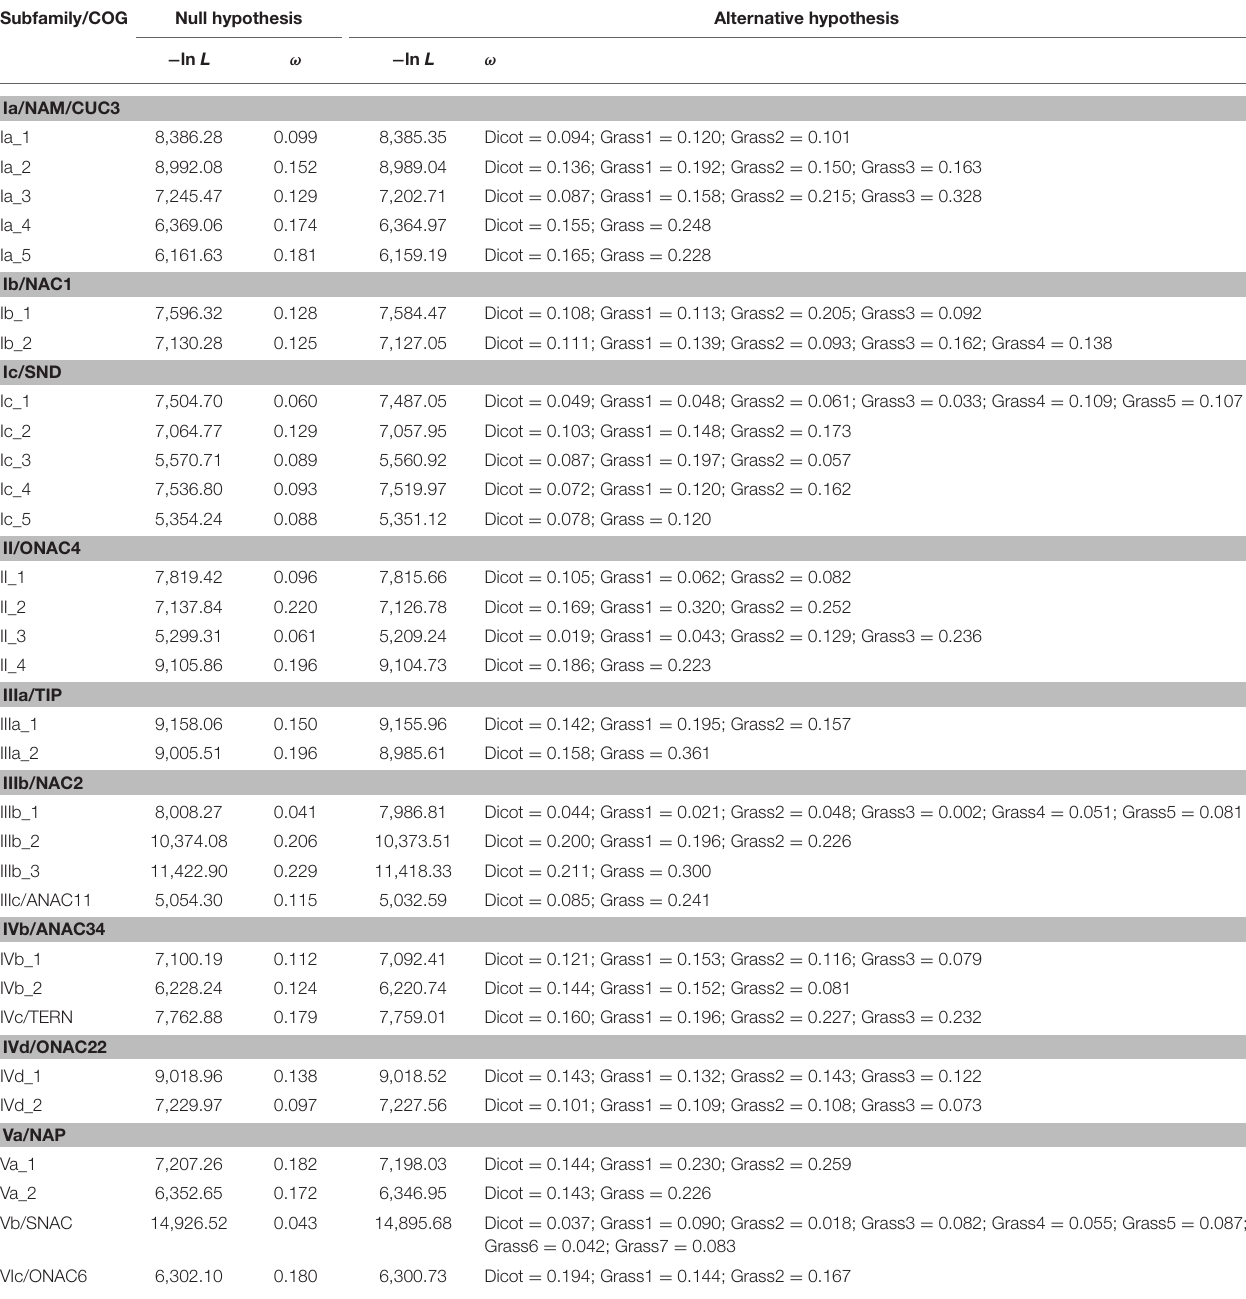
TABLE 2 | Statistics of the parameters from branch model of PAML. Subfamily/COG Null hypothesis Alternative